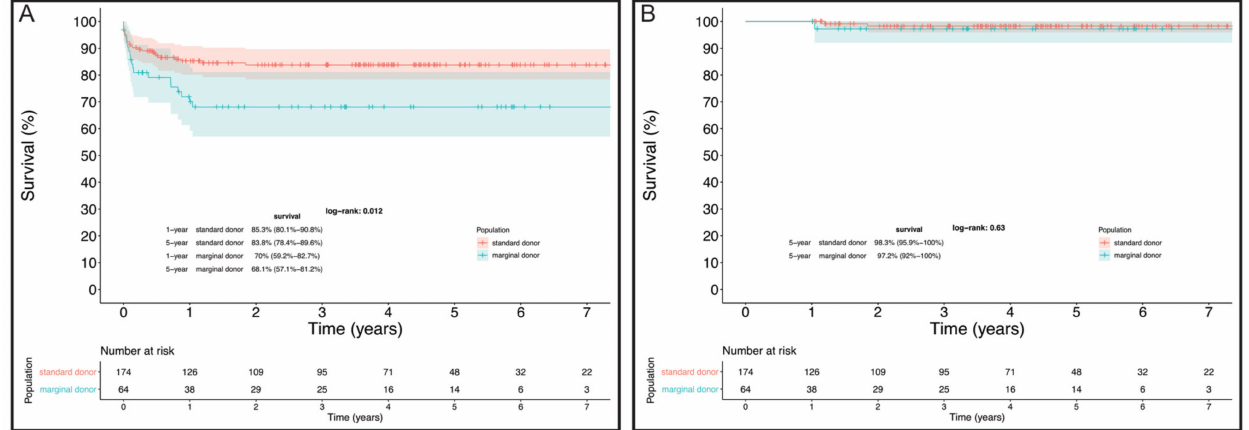
Figure 3. ( A ) Overall survival in SDs compared to MDs; ( B ) 5-year conditional survival of MDs compared to